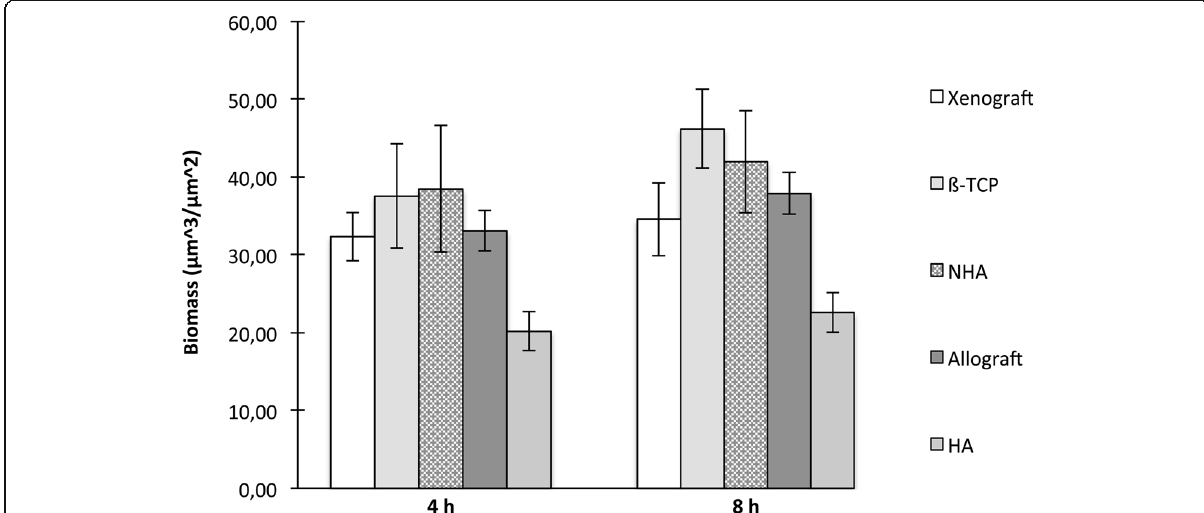
Fig. 2 Quantitative analysis of the biofilm formed by A. fumigatus on five different bone substitutes. Xenograft: anorganic bovine bone; ß-TCP: ß- tricalcium phosphate; NHA: synthetic nano-hydroxyapatite; Allograft: demineralized bone matrix; HA: synthetic hydroxyapatite. Biomass evaluation was assessed in a 20-h-old biofilm produced by conidia tightly bound to the bone substitutes after 4 and 8 h adhesion times. For each sample, twelve confocal laser scanning microscope (CLSM) image stacks were acquired at random positions and the biomass was quantified by COMSTAT analysis. Results are expressed as the mean values among 12 CLSM image stacks ± SD, represented by the error bars. For each adhesion time, comparison between materials was made with the Kruskal – Wallis test for non-normally distributed data: p values are reported